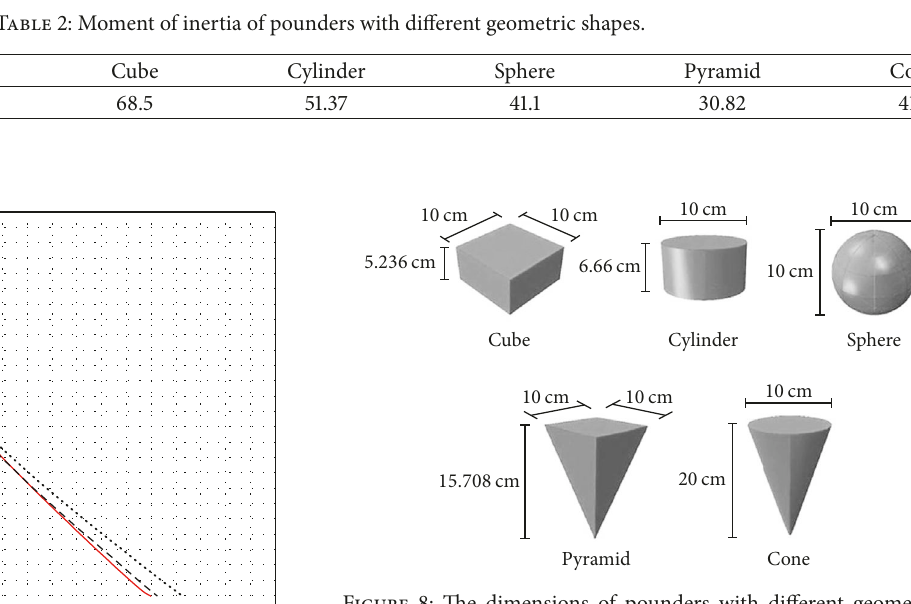
Figure 8: The dimensions of pounders with different geometric shapes.